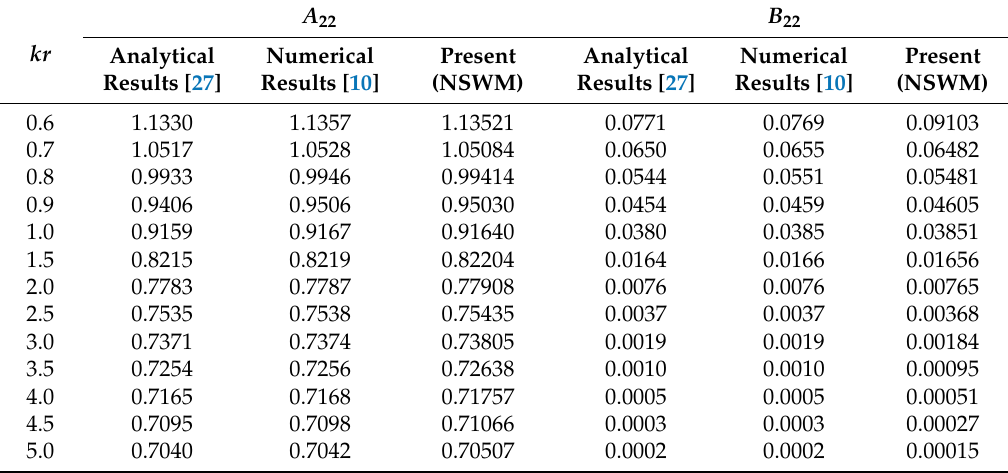
Table 4. Added masses and damping coe ffi cients of the sphere in sway motion ( Fr = 0.4, h = 2.0 r , k ec r =